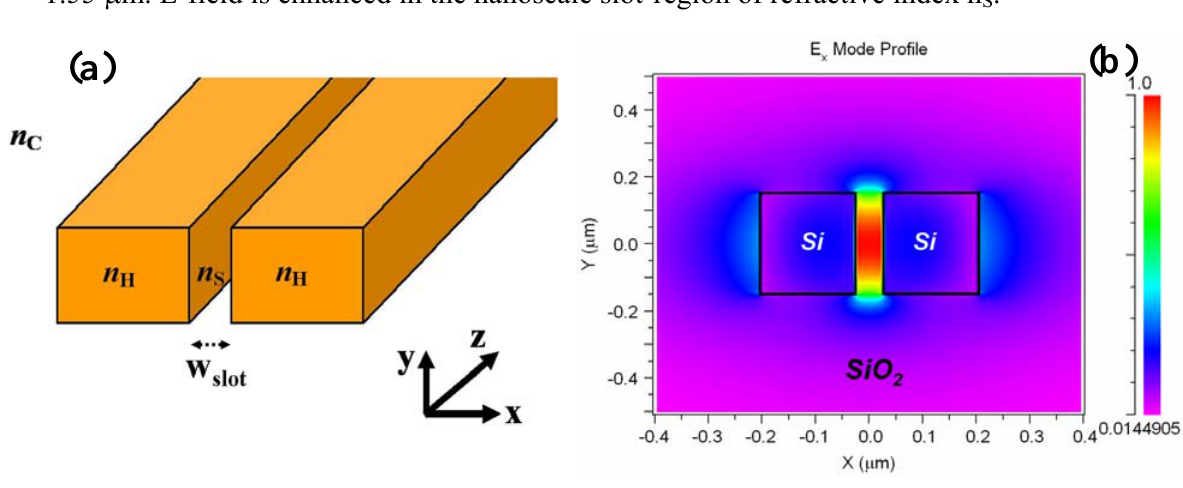
Figure 1. (a) Schematic view of a slot-waveguide. (b) Calculated E TE eigenmode in a Si (n